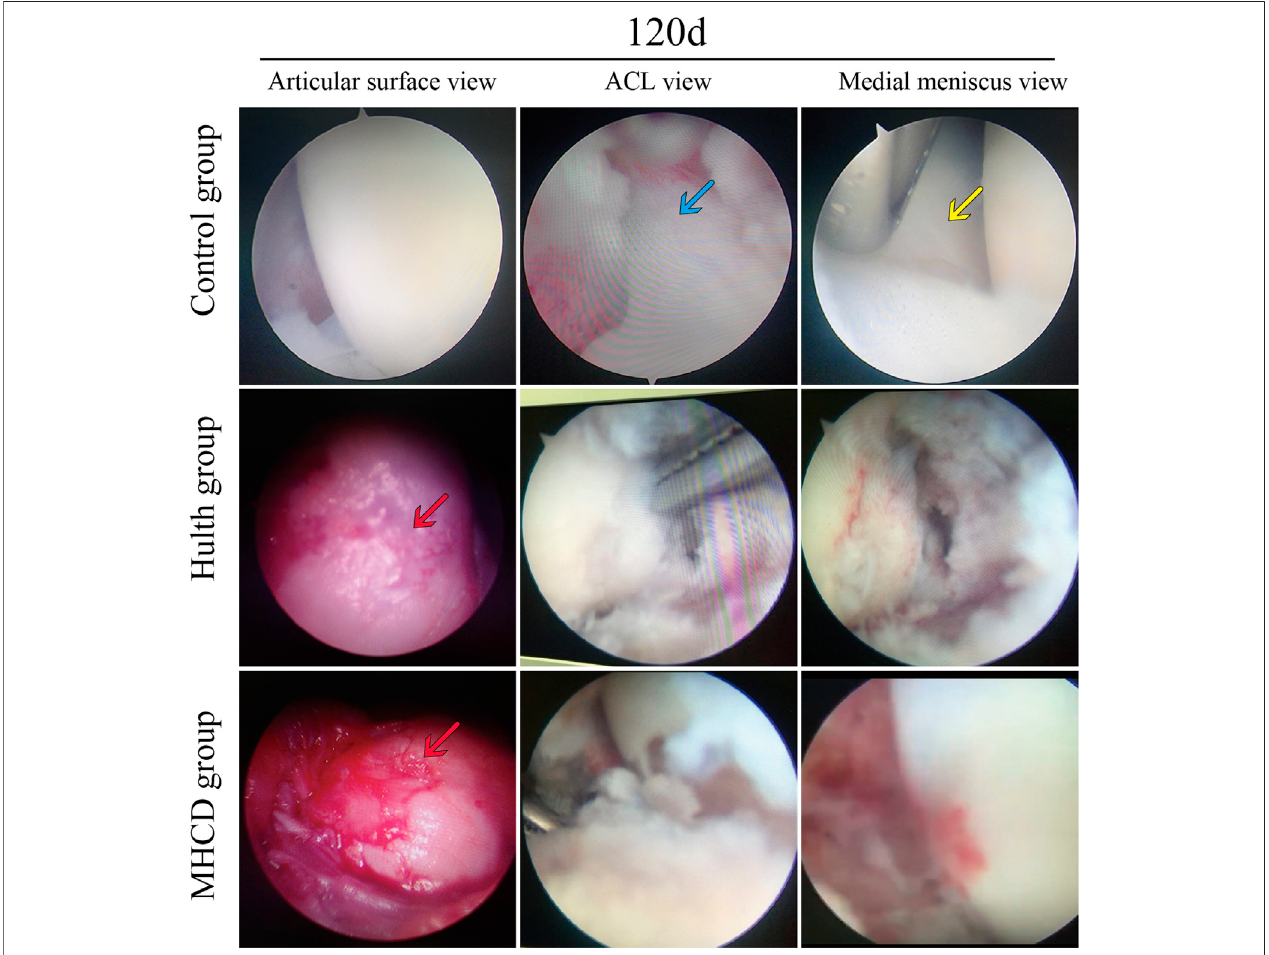
FIGURE5| Representativearthroscopic fi ndingsofthekneejointsofrhesusmacaquesfromtheControl,Hulth,andMHCDgroupsonDay120(bluearrows,ACL; yellow arrows, medial meniscus; red arrows, cartilage defects).